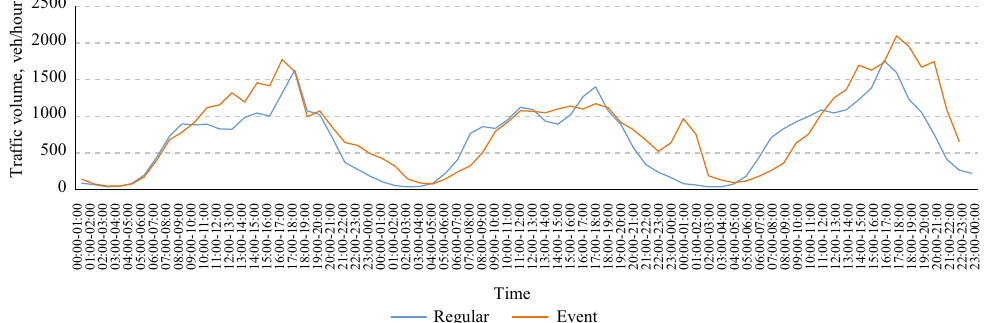
Figure 5. Distribution of traffic flow by hour outward Klaipėda during “The Sea Festival” and on a regular